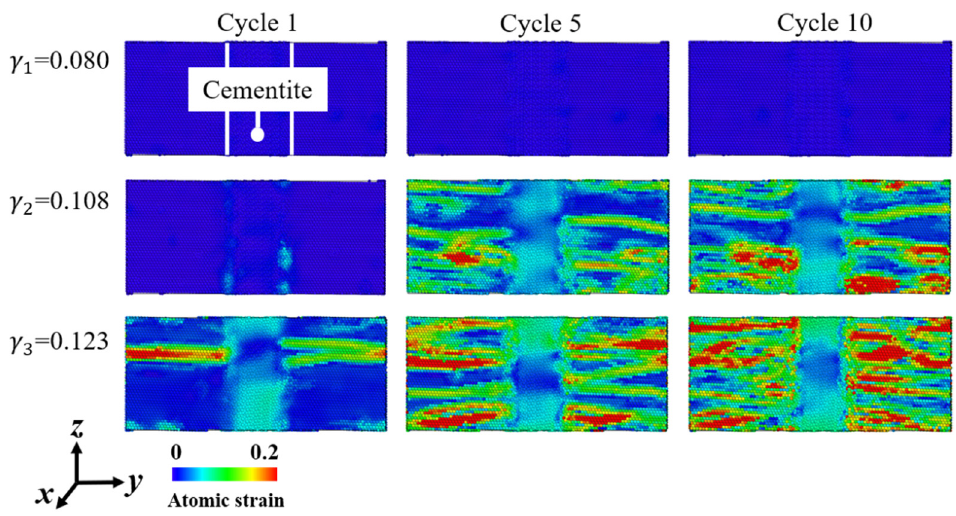
Figure 13. Evolution of high-strain atoms in the model under different shear strain levels when shear deformation is along y -axis.